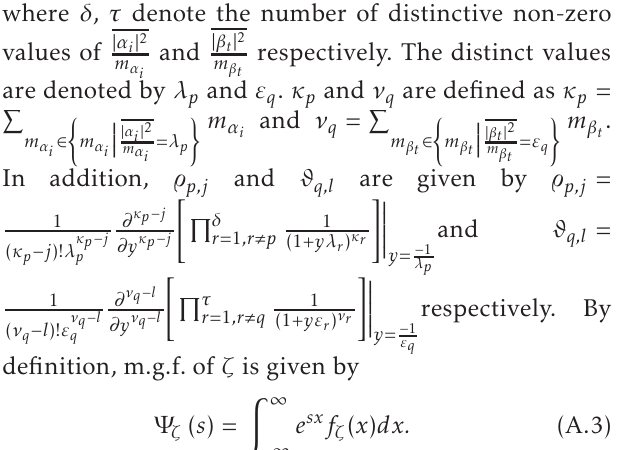
Figure 9. SEP performance of G parameters equal to 1